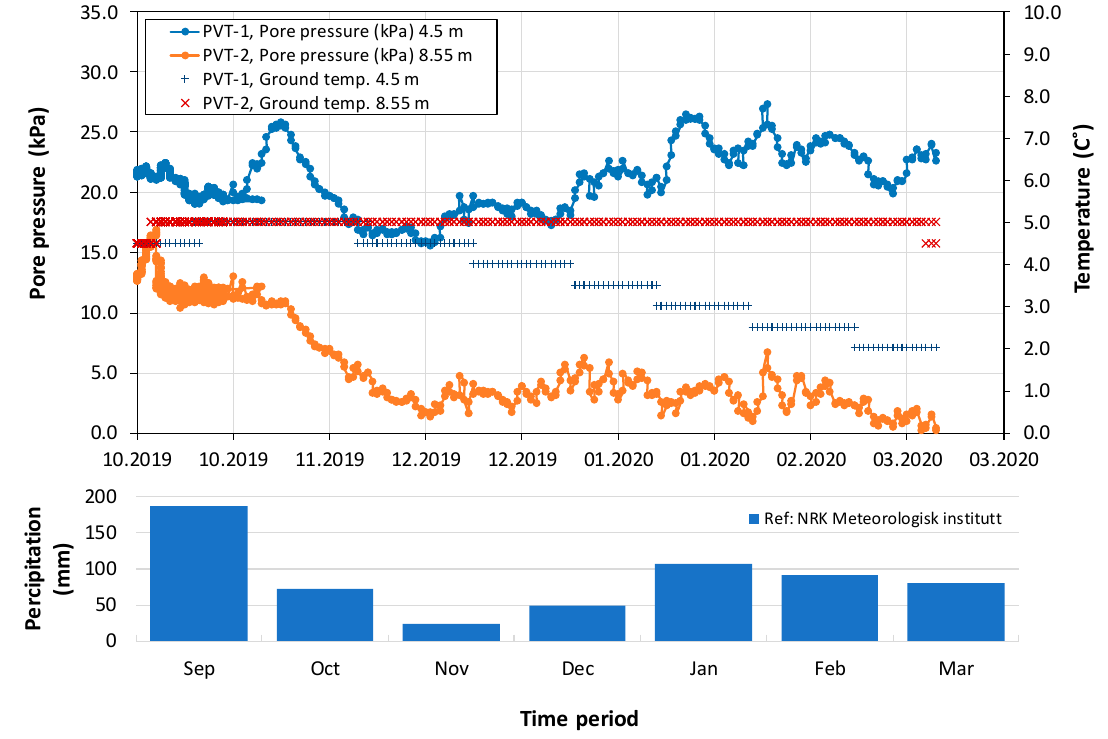
Figure 12. Measured pore water pressure and ground temperature by PVT 1 and PVT 2.